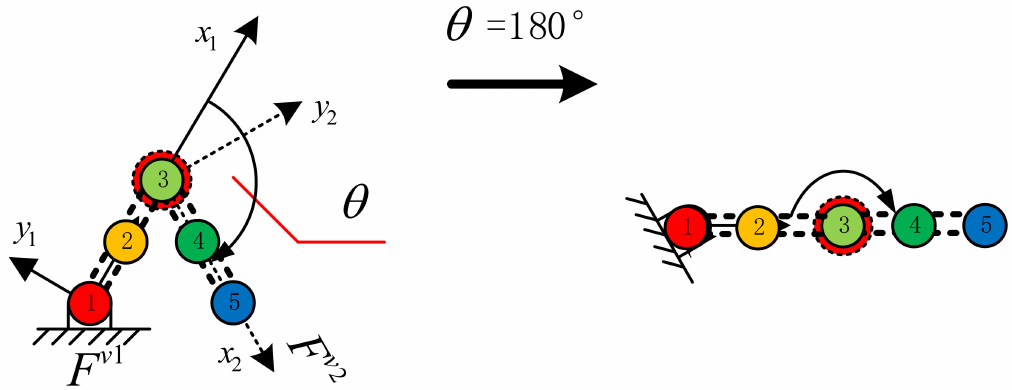
Figure 18. Predefined virtual linkage used in these two